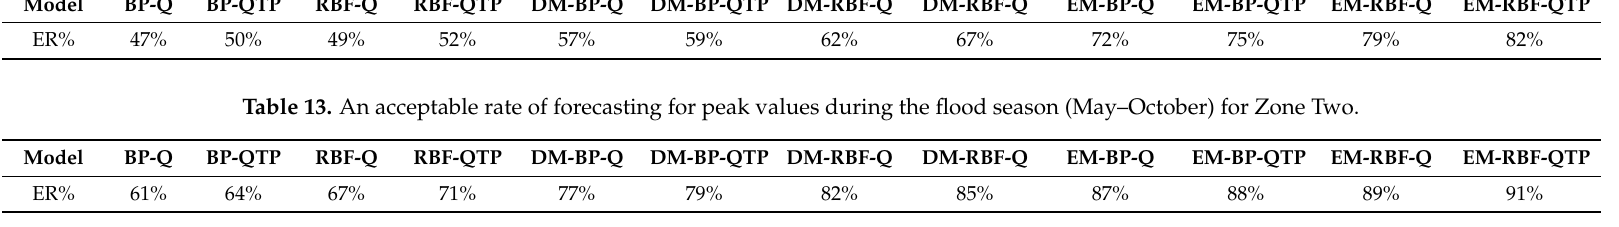
Table 12. An acceptable rate of forecasting for peak values during the flood season (May–October) for Zone One. Model